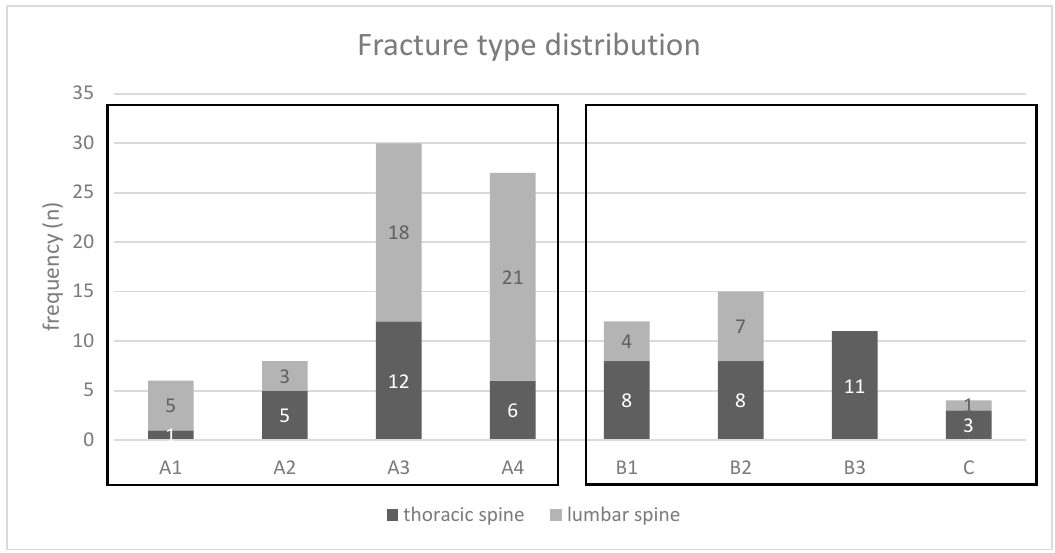
Figure 1. Flowsheet of the included population.